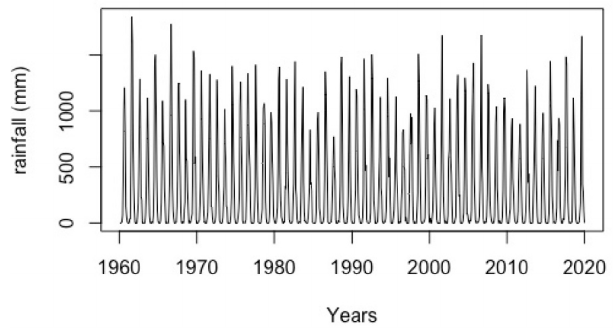
Figure 5. Monthly rainfall record time series recorded in Conakry (Guinea) from 1960 to 2019. The time axis is expressed in